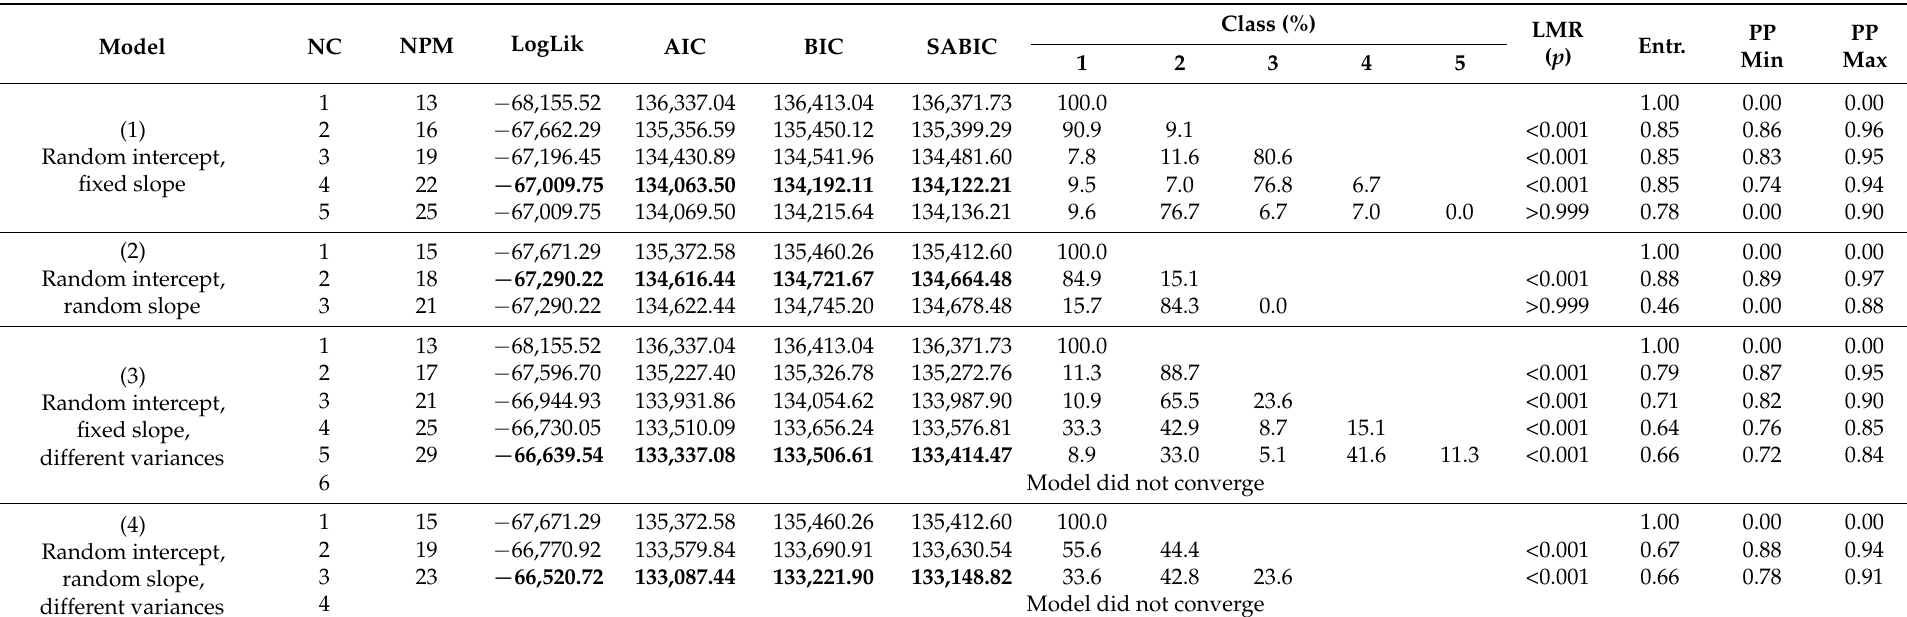
Table A4. Multivariate Latent Class Growth Analysis for PHQ-9, GAD-7, PCL-5 and RPQ ( N =